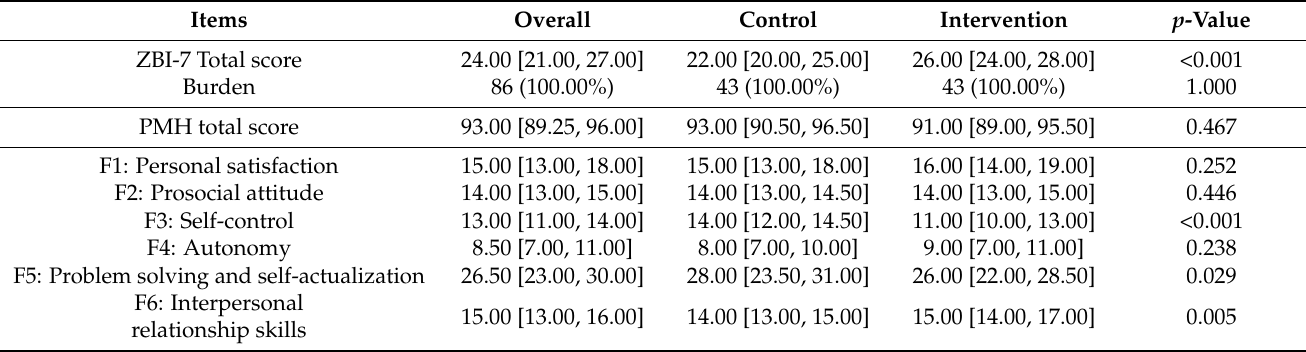
Table 2. Direct scores and by levels on baseline scales in the overall sample and in the control and intervention groups.